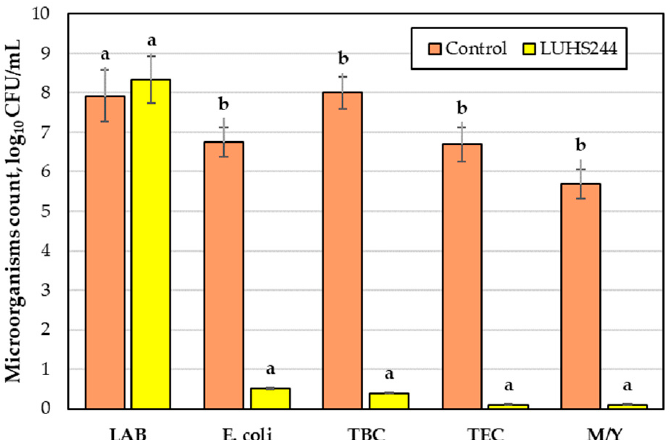
Figure 7. Bovine colostrum microbiological parameters. LAB—lactic acid bacteria; E. coli — Escherichia coli ; TBC—total bacteria count; TEC—total enterobacteria count, M/Y—mould and yeast, Control—non-treated bovine colostrum, LUHS244—bovine colostrum fermented with Lacticaseibacillus paracasei LUHS244. Data are represented as means (n = 3) ± standard error; a–b mean values within a line with different letters are significantly different ( p ≤ 0.05).